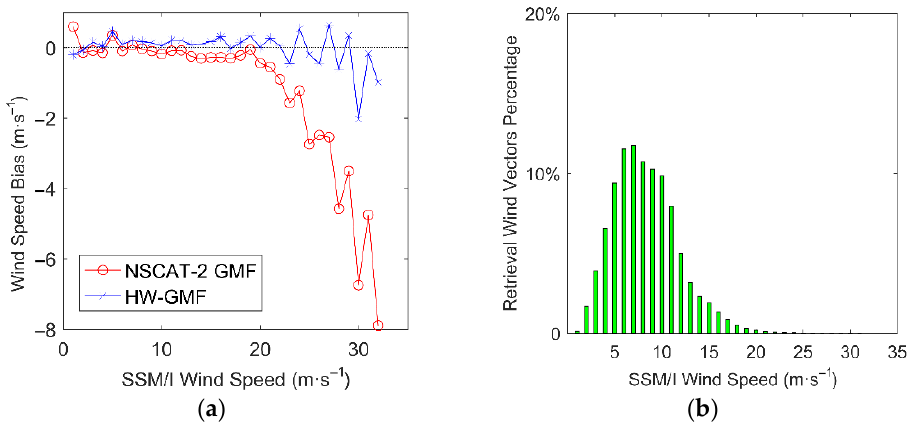
Figure 9. Dependence of wind speed residual and percentage of the retrieved wind vectors on the SSM/I wind speed. ( a ) The result of error verification. The red circle in the figure is the mean value of deviation of the NSCAT-2 GMF retrieved wind speed minus the SSM/I wind speed, and the blue asterisk is the mean value of deviation of the HW-GMF retrieved wind speed minus the SSM/I wind speed. The dashed line in the figure represents a wind speed bias of 0. ( b ) The histogram of percentage of the retrieved wind vectors.